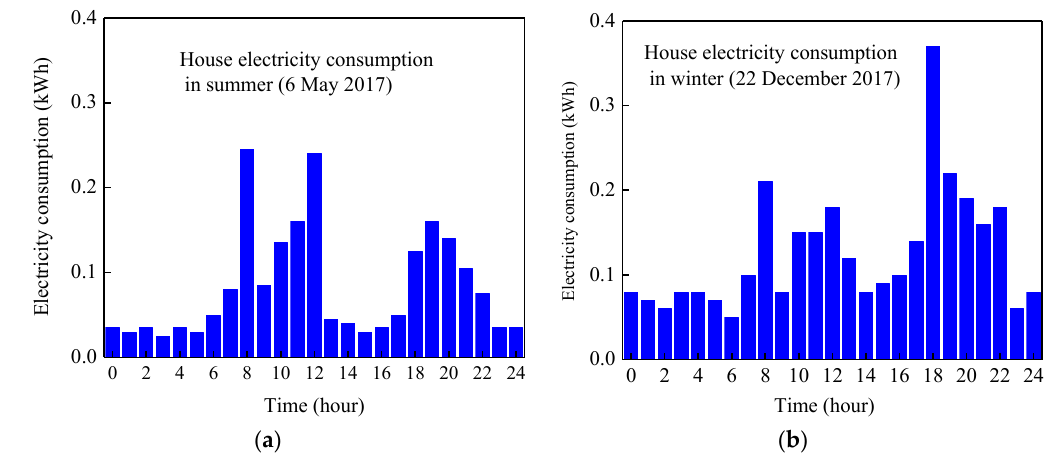
Figure 2. Typical daily profile of electricity consumption ( a ) in summer and ( b ) in winter.